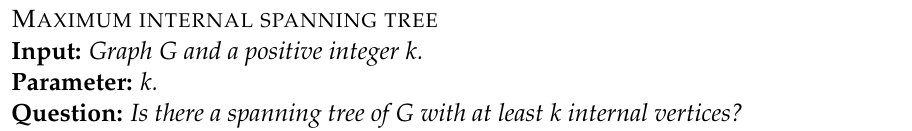
Box 27. Maximum Internal Spanning Tree